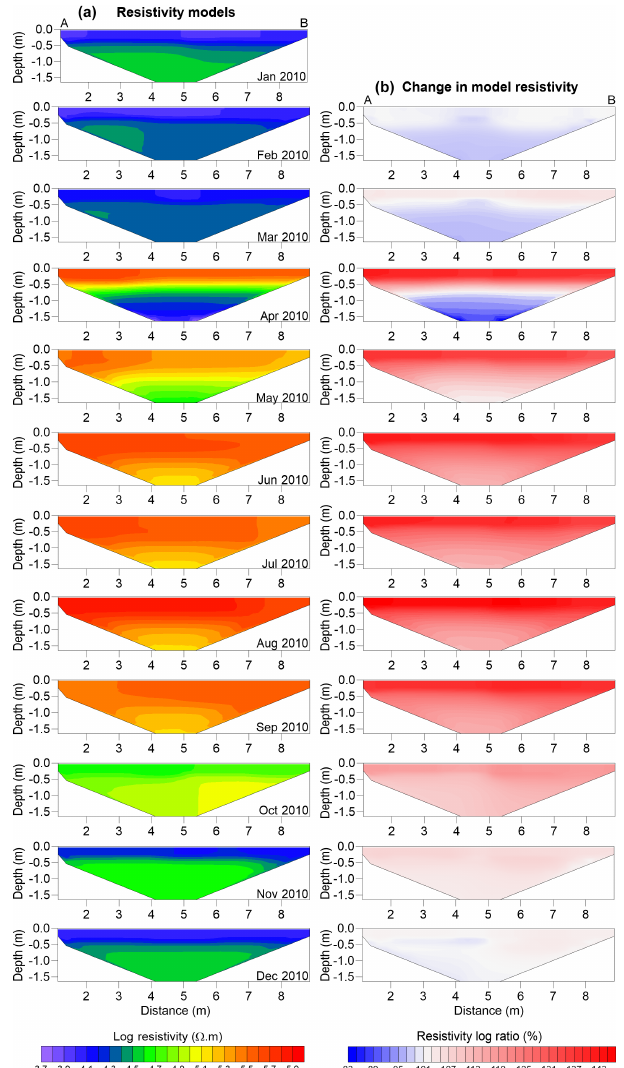
Figure 7. (a) Inverted resistivity tomograms of 12 monthly spaced A-ERT datasets between January and December 2010, based on data measured on the 28th of each month, and (b) relative resistivity changes based on the first ERT dataset referred to